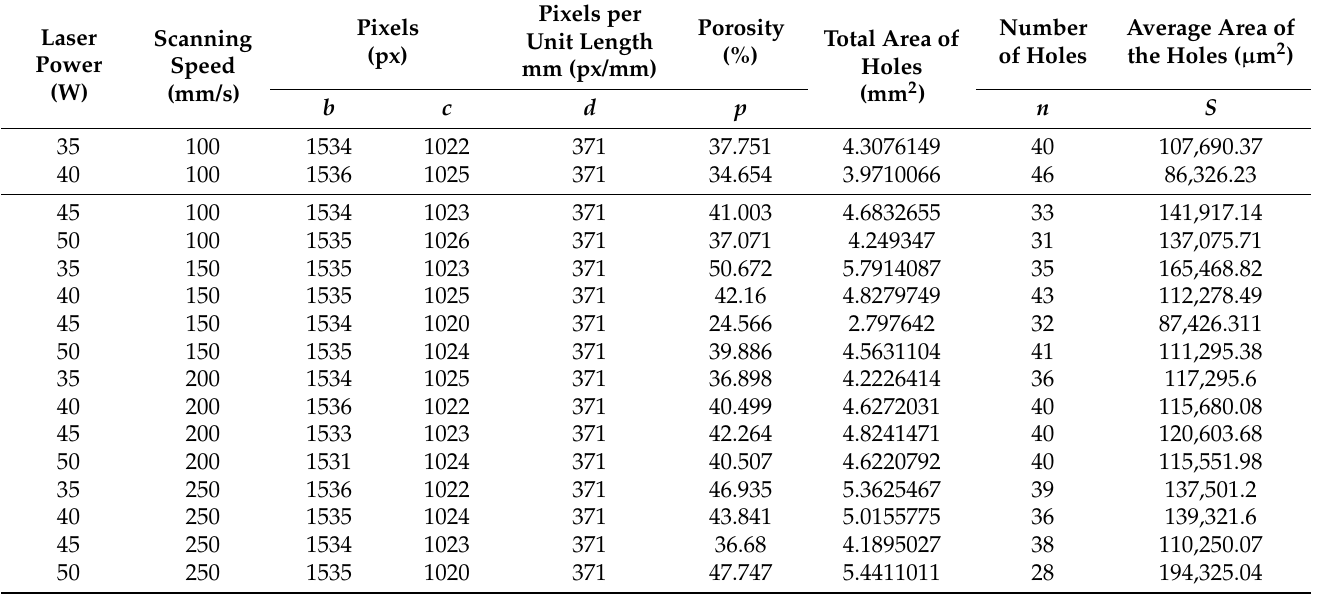
Figure 11. Average area distributions of the pores in the low-magnification SEM images of the ISLF samples. Table 4. The data used to calculate the average area of the holes.